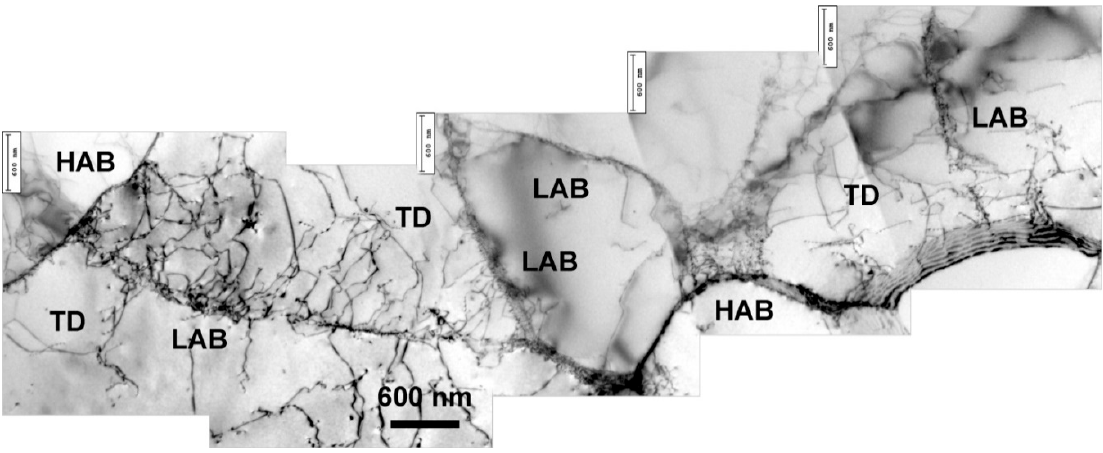
Figure 5. Montage of TEM micrographs showing a representative example of a progressive evolution from Tangled dislocations (TDs) to LABs (cell boundaries) and then to HABs (grain boundaries); 6N-Al at ε eq = 0.10.